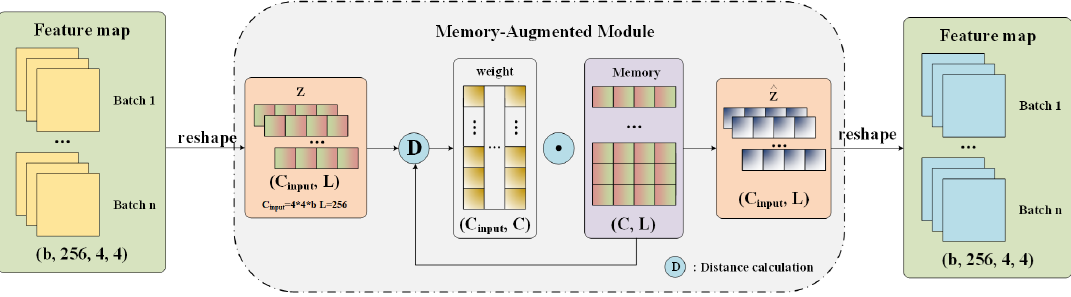
Figure 6. Details of the memory-augmented